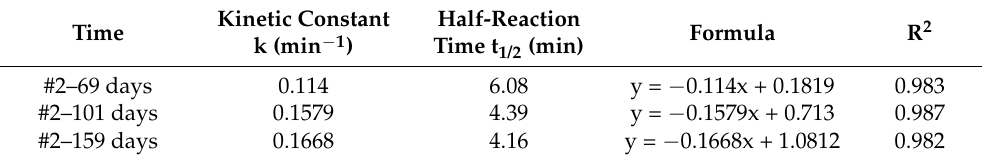
Table 7. Linear regression analysis of the biological manganese removal at different